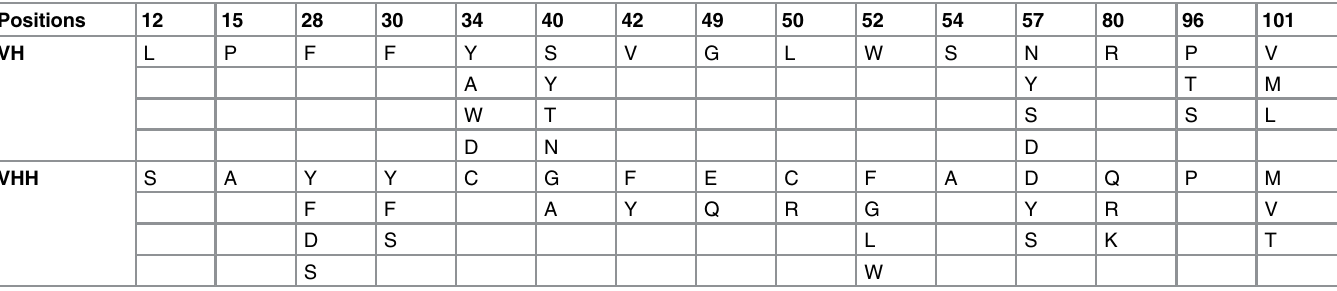
Positions refer to the absolute position of the amino acids in IMGT references of the Arabian camel. VH and VHH denote the clones of the variable regions of conventional antibodies and HCAbs, respectively. Single letters in the table are abbreviations for amino acids. Multiple AAs are included at some positions to add up to a combined appearance frequency of > 50%. The AA appearance frequency (shown in S1 File.) at a position is de fi ned as: (total speci fi c AA) / (total AAs at that